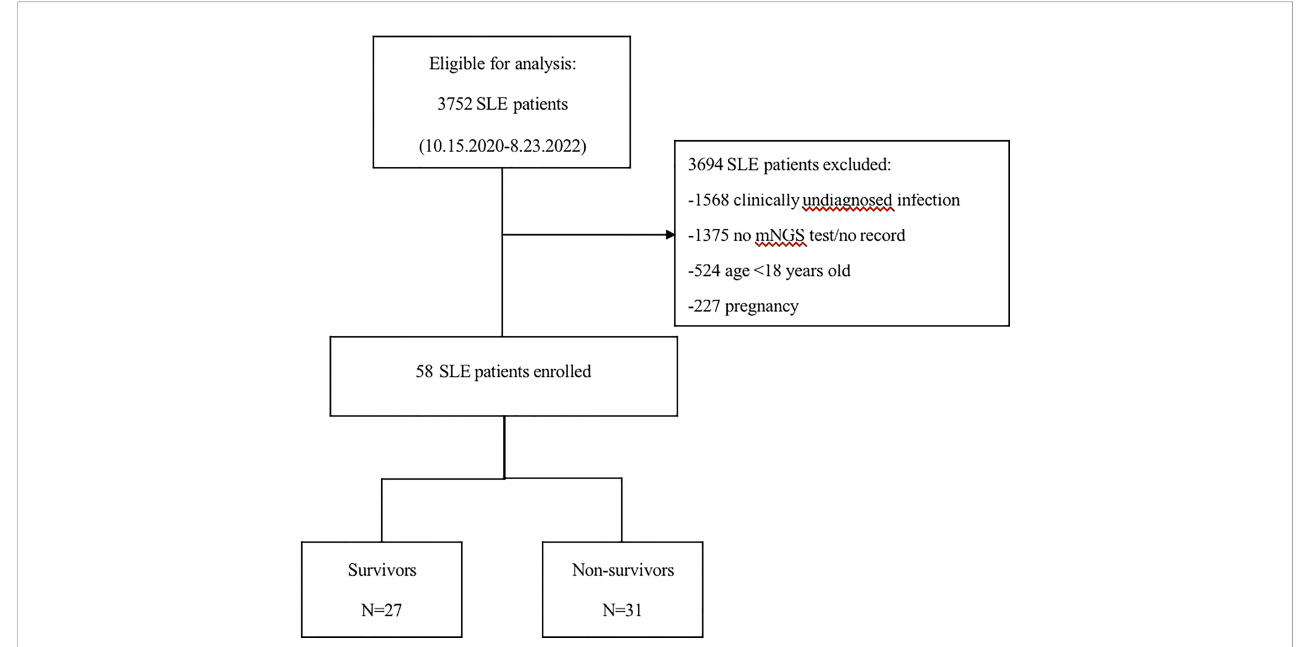
FIGURE 1 Flow chart of analyzed patients. SLE, systemic lupus erythematosus; mNGS, metagenomic next-generation